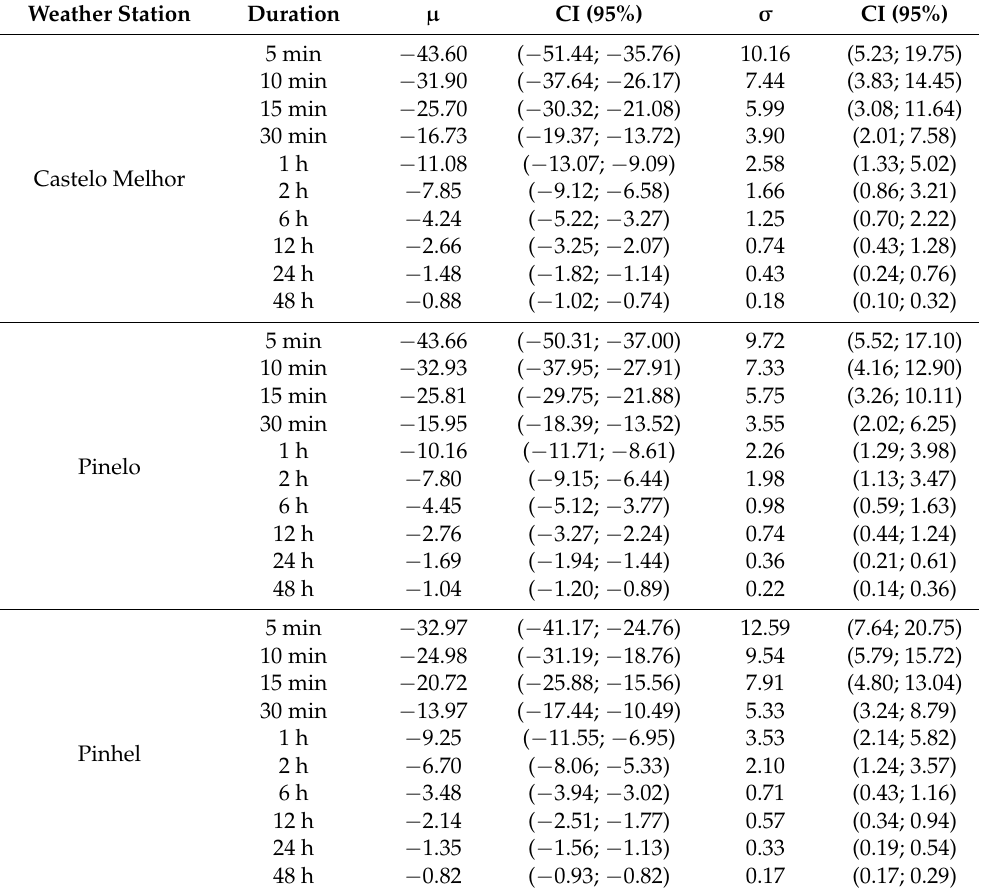
Table 2. Results of the Gumbel distribution function fitting to time series of maximum rainfall intensity for ten different durations, using rainfall data observed in the 3 weather stations (Table 1), including: Maximum likelihood estimates of the location ( µ ) and scale ( σ ) parameters; 95% confidence interval (CI). The Kolmogorov-Smirnov statistical test was performed in all cases and the results confirm that the null hypothesis (maximum rainfall intensity is statistically distributed according to the Gumbel function) cannot be rejected at the 5% significance level (i.e., p -value <